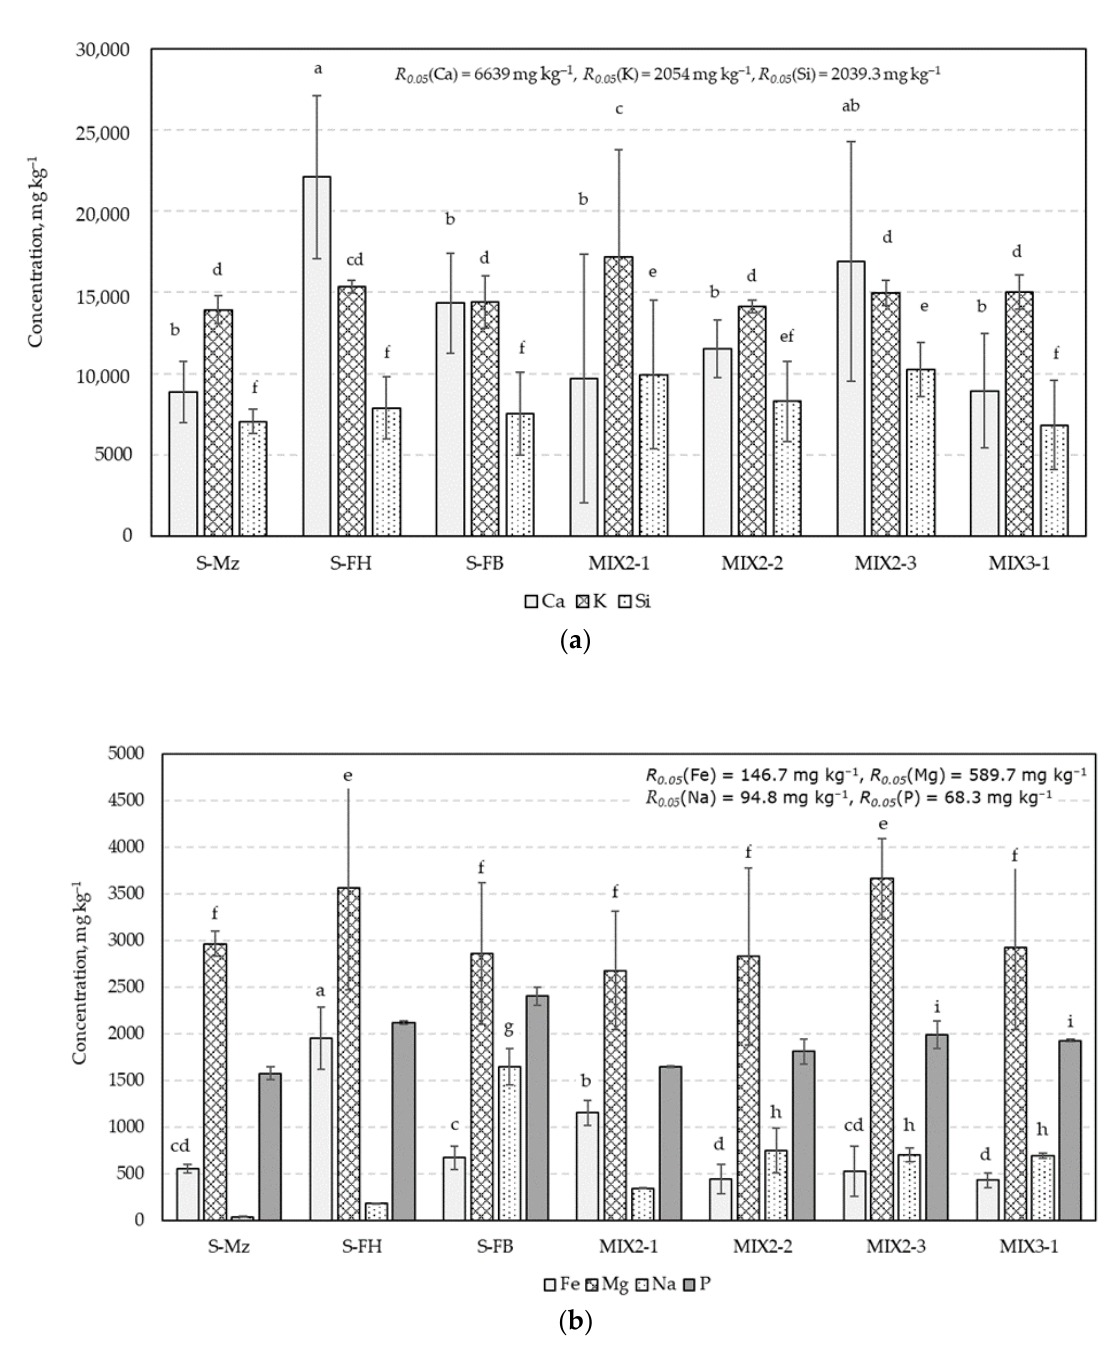
Figure 3. Results of macronutrient analysis of produced pellets: ( a ) Ca, K, and Si analysis; ( b ) Fe, Mg, Na, and P analysis. In the figures, any two samples with a common letter are not significantly different, as assessed using the least significant difference.